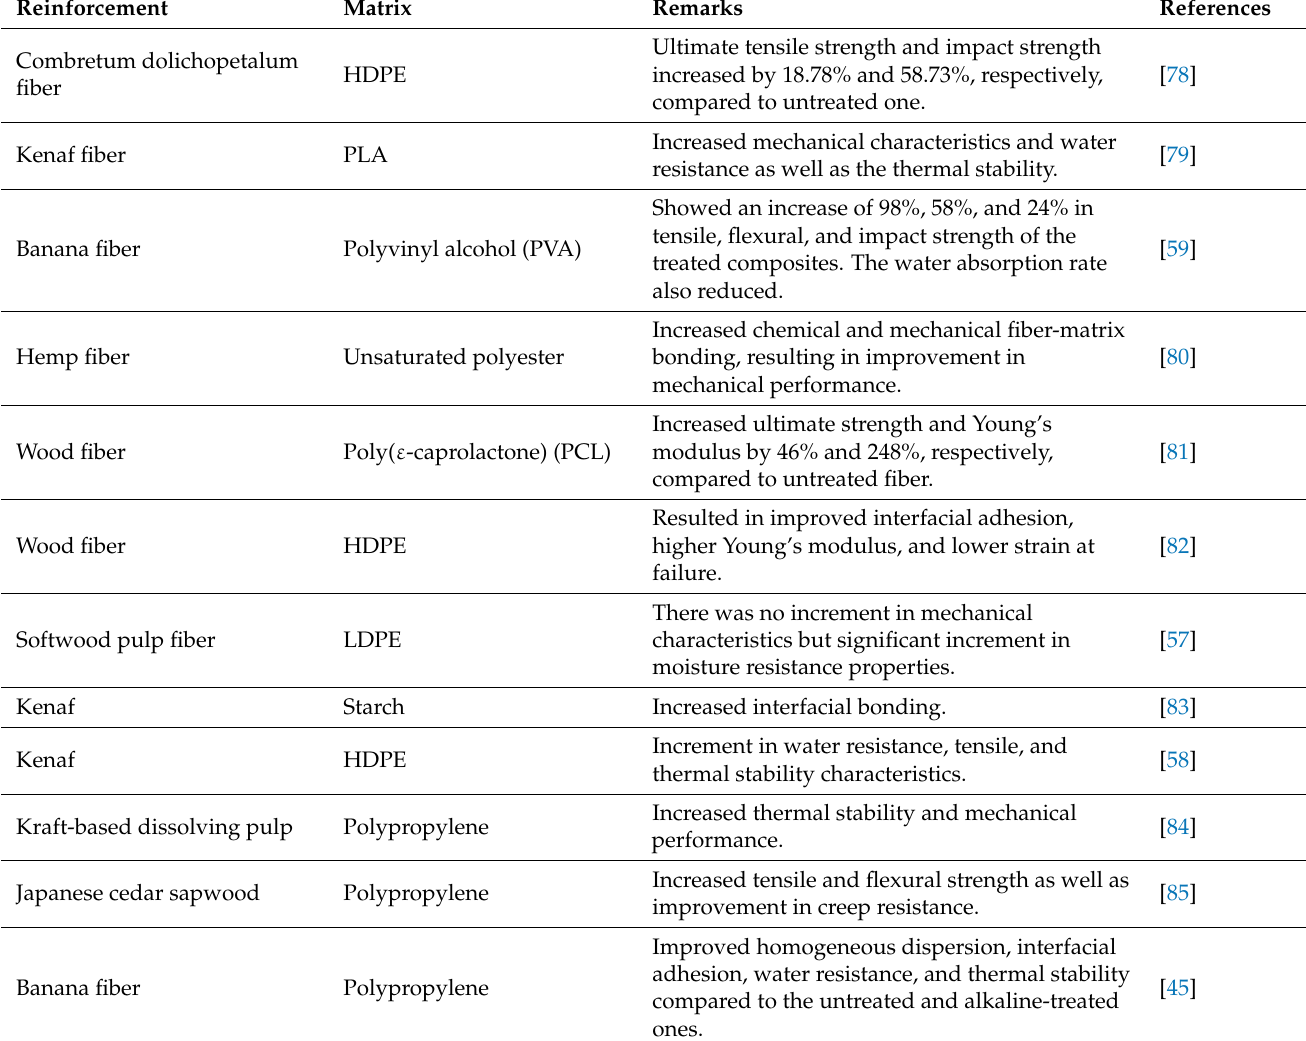
Table 4 reviews the effect of acetylation treatment on the performance of the composites. Table 4. Effect of acetylation